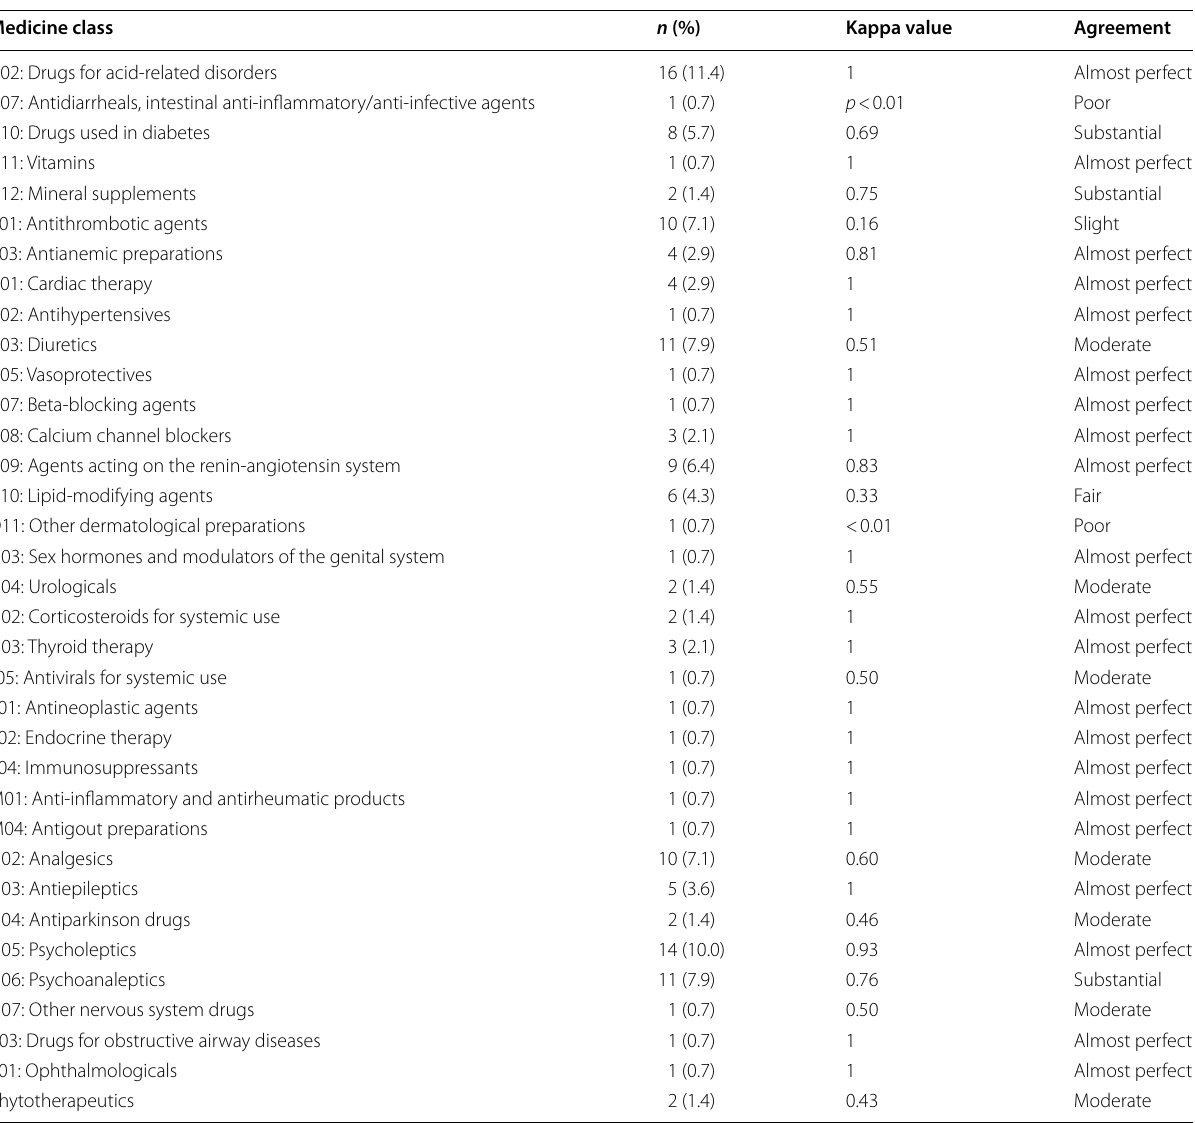
Table 3 Absolute agreement among eight pharmaceutical observers following the application of the guide, listed according to ATC